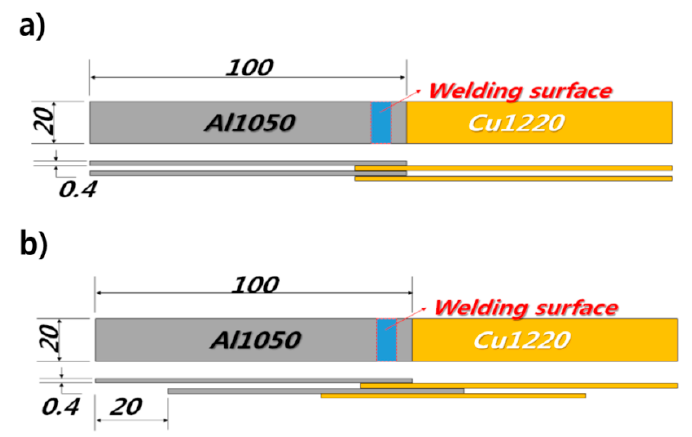
Figure 3. Configuration of welding specimen.